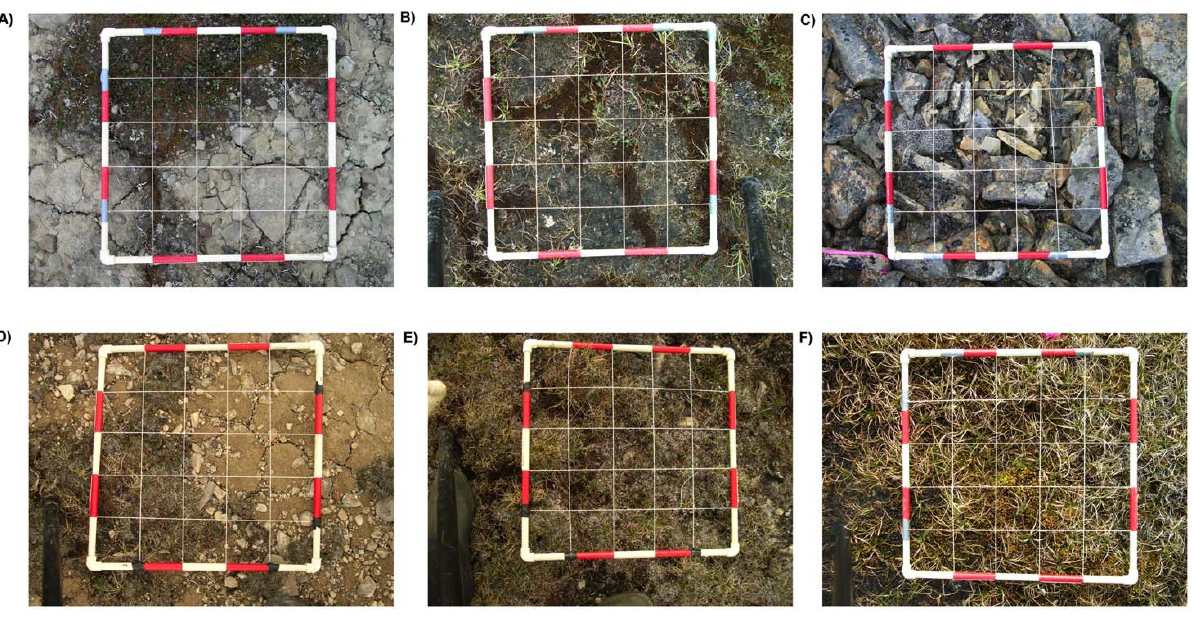
Figure 7. Representative images of the final ecological classes. ( A ) Dry P. radicatum and Till Tundra; ( B ) Mesic Nostoc Tundra; ( C ) Felsenmeer; ( D ) Dry Dryas spp. and Till Tundra; ( E ) Mesic Dryas spp. Tundra; and ( E ) Wet Sedge